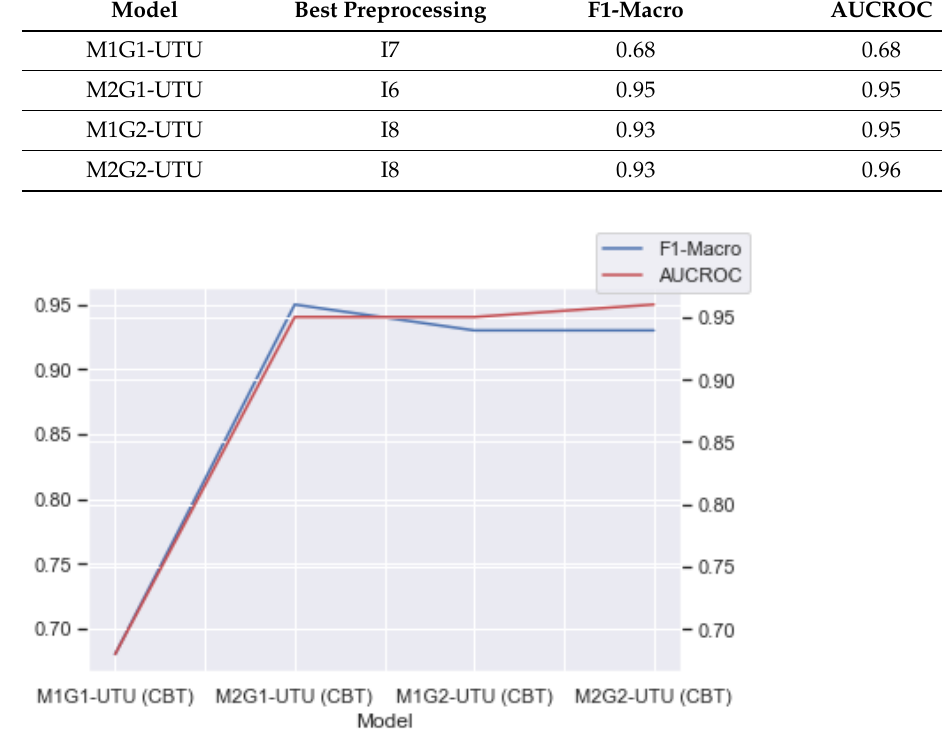
Figure 6. Performance of the models through the grades for the UTU